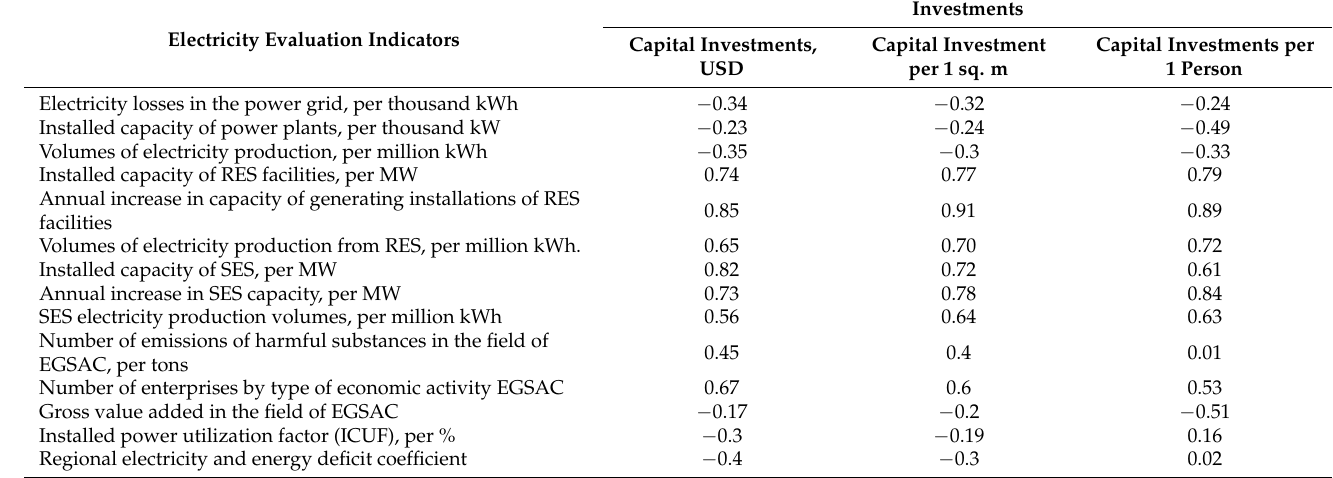
Table 2. Estimation of the density of the relationship between investment indicators and indicators for assessing the performance of the power complex of South-Eastern Ukraine (correlation